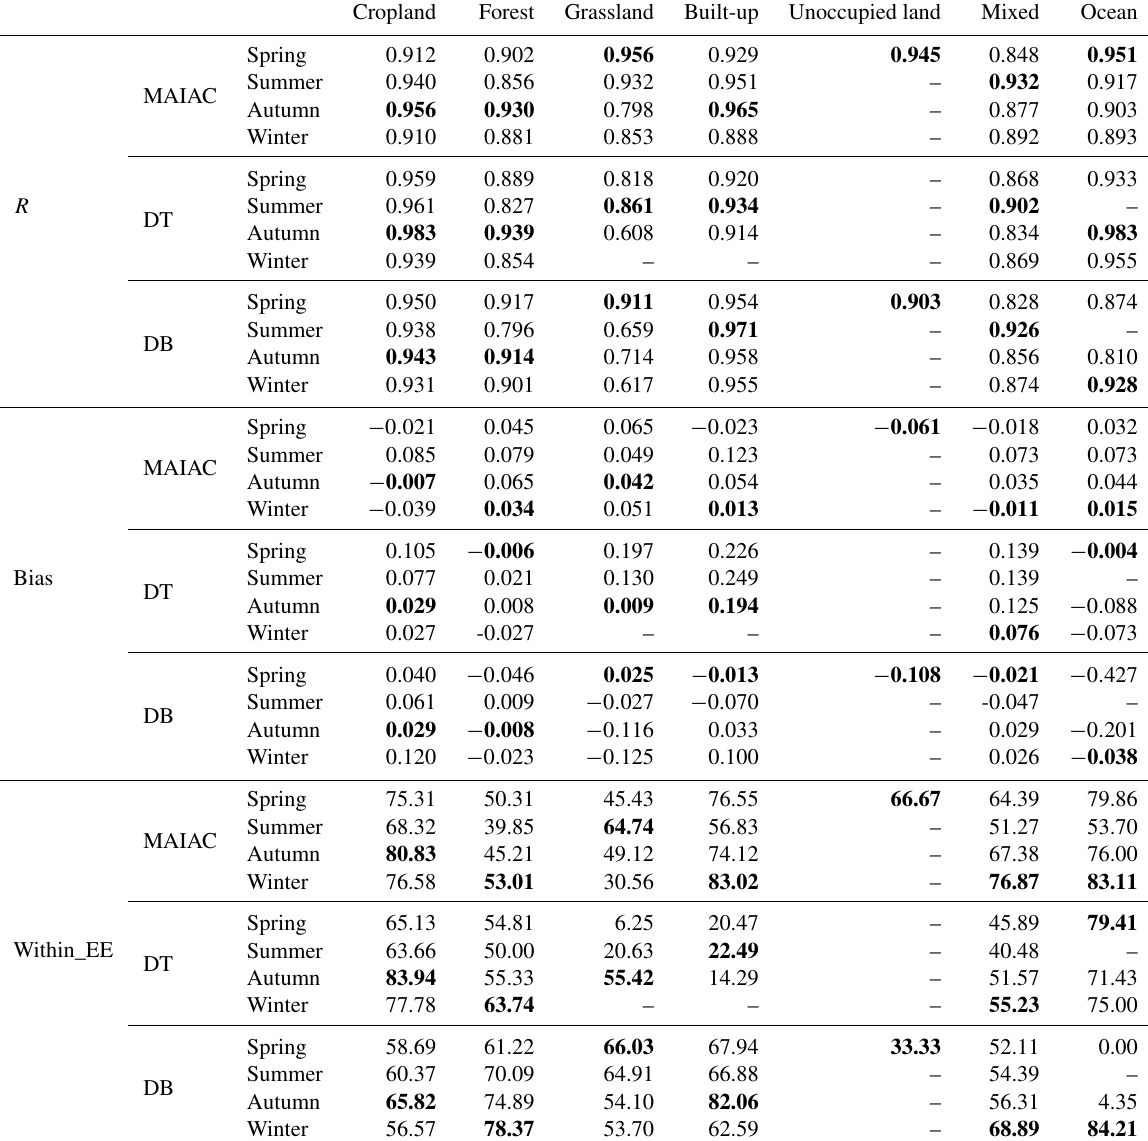
Table 5. Comparison of the retrieval accuracy of the MAIAC, DT, and DB products for different land cover types in four seasons after the QA filter. “–” means no matchup pairs or that the matchup pairs number fewer than 10. The bold number is the highest peformance among four seasons by each